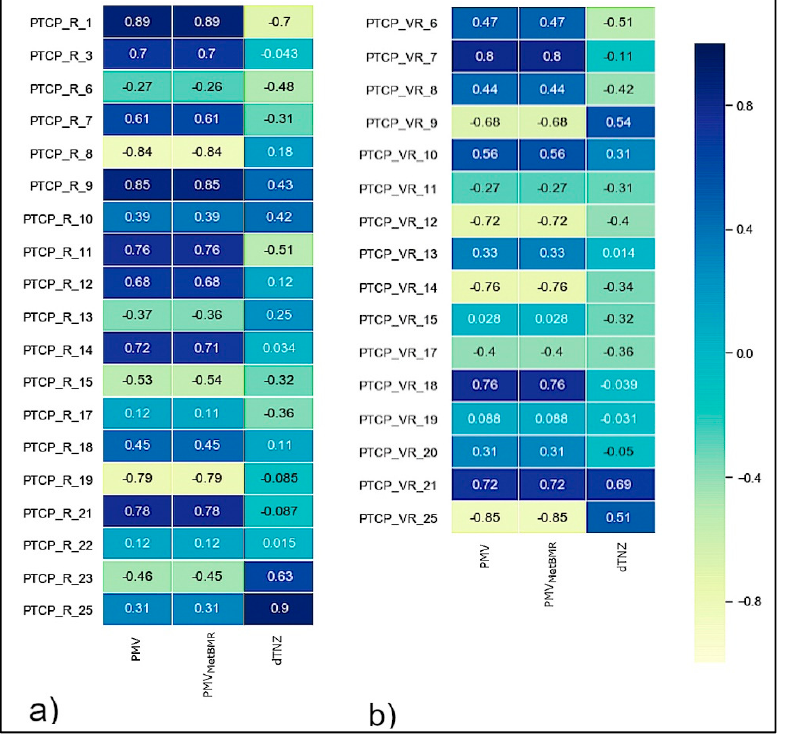
Figure 7. Confusion correlation matrix of: ( a ) PTCP_R; ( b ) PTCP_VR.